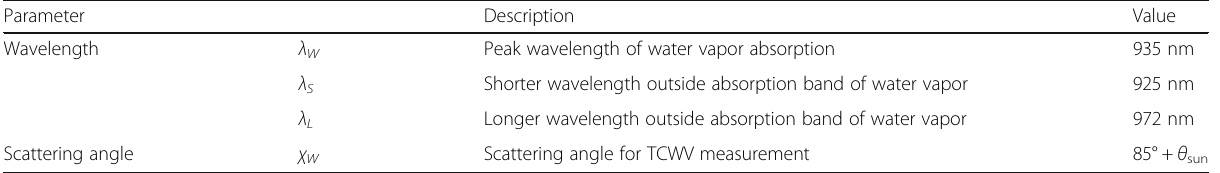
Table 6 Wavelengths and a scattering angle chosen for TCWV measurement Parameter